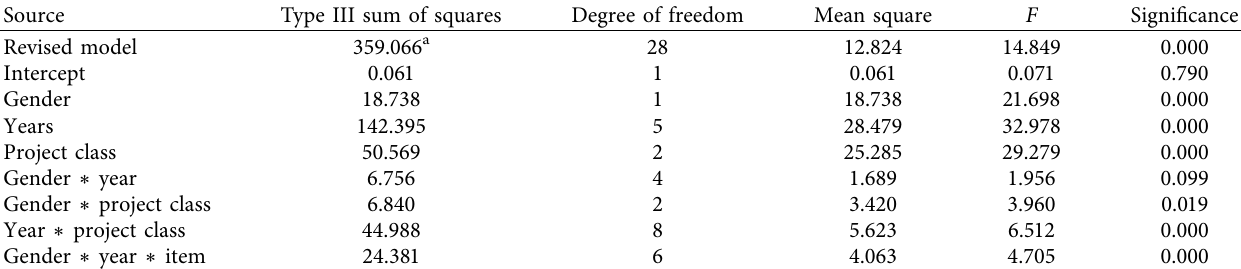
Table 3: Analysis of differences in reaction time of athletes in different race